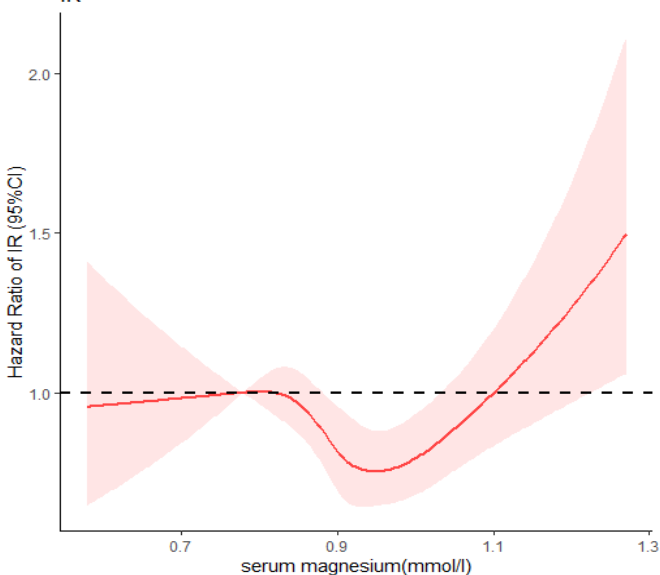
Figure 1. Restricted cubic spline of association between serum magnesium and IR (HOMA-IR ≥ 2.5). The result of the dose–response relationship between serum magnesium levels and Type 2 diabetes mellitus in the RCS model showed that the hazard ratio of Type 2 diabetes and serum magnesium displayed a similar nonlinear relationship (nonlinear p < 0.001) comparing the relationship of IR and serum magnesium. V-shaped correlation was found when setting the 5th percentile of serum magnesium level (0.78 mmol/L) as a reference. When serum magnesium level was less than approximately 0.93 mmol/L, the risk